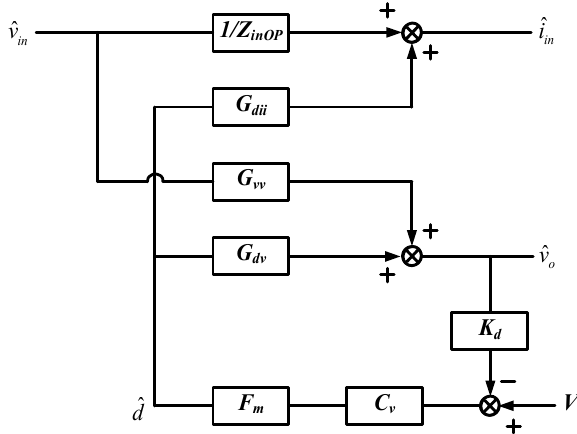
Figure 7. Control block diagram of Buck converter with voltage mode control.